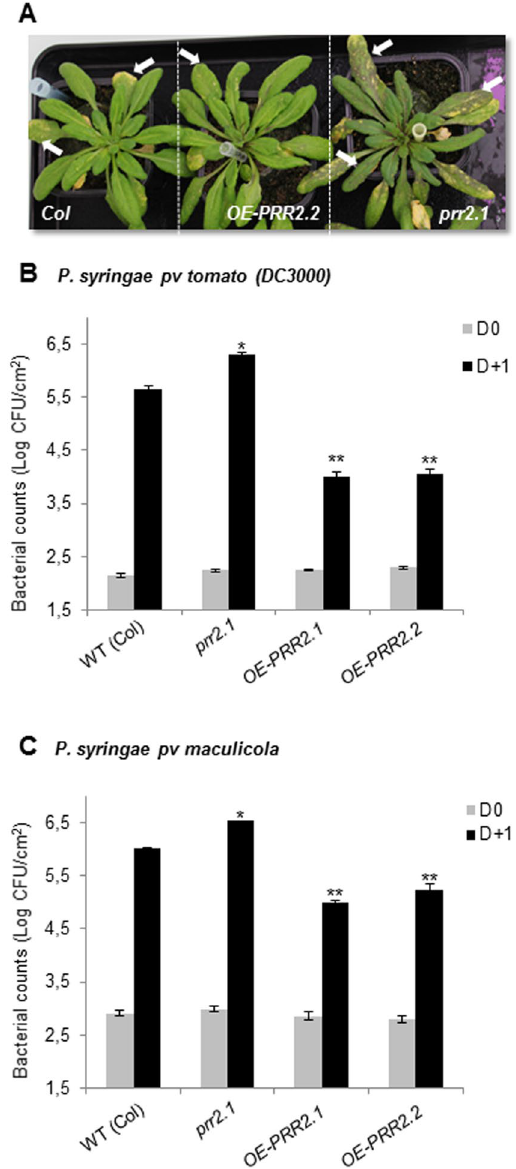
Figure 3. Altered susceptibility to Pseudomonas syringae in prr2 knock-down mutants and in transgenic lines overexpressing PRR2 . ( A ) Disease symptoms observed in 4-week-old Arabidopsis leaves (WT (Col), OE-PRR2 . 2 and prr2 . 1 ) caused by Pst DC3000 infection. Leaves were sprayed with 5.10 7 cfu.mL − 1 of Pst DC3000 and pictures were taken 7 days post-infection. Arrows indicate leaves exhibiting pronounced chlorosis symptoms. ( B and C ) Quantification of in planta bacterial growth were performed at 0 and 1 dpi with Pst DC3000 ( B ) or Pseudomonas syringae pv maculicola ( C ) in WT (Col), prr2 . 1 mutant and over-expressing transgenic lines OE-PRR2 . 1 and OE-PRR2 . 2 . Data are representatives of 8 replicates from three independent experiments (n = 24). Error bars indicate SE. P values were calculated using the two-tailed Mann-Whitney U-test to indicate significant differences in bacterial growth in these different genetic backgrounds compared to WT ( * p < 0.05, ** p <